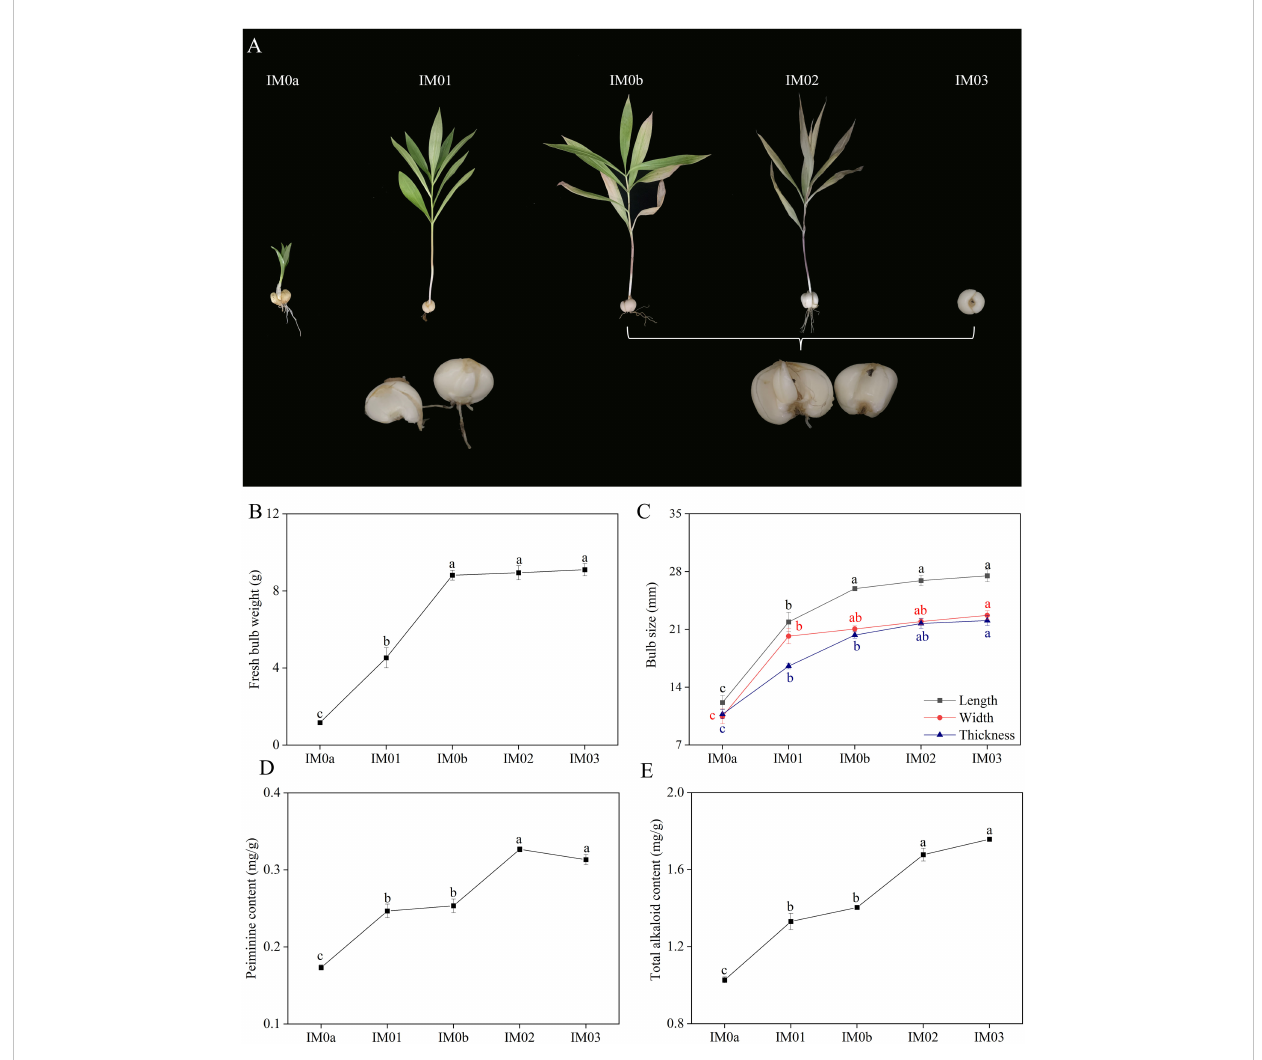
FIGURE 2 Dynamic phenotypic and biochemical variations in regenerated bulb development of F. hupehensis . (A) . Phenotypic changes in ( F ) hupehensis at fi ve developmental stages. (B) . Bulb size (length, width, and thickness) changes. (C) . Details of changes in fresh bulb weight. (D) . Details of changes in peiminine content. (E) . Details of changes in total alkaloid content. All data in the Figure are represented as mean ± standard error. Different letters in each system represent signi fi cant differences at p<